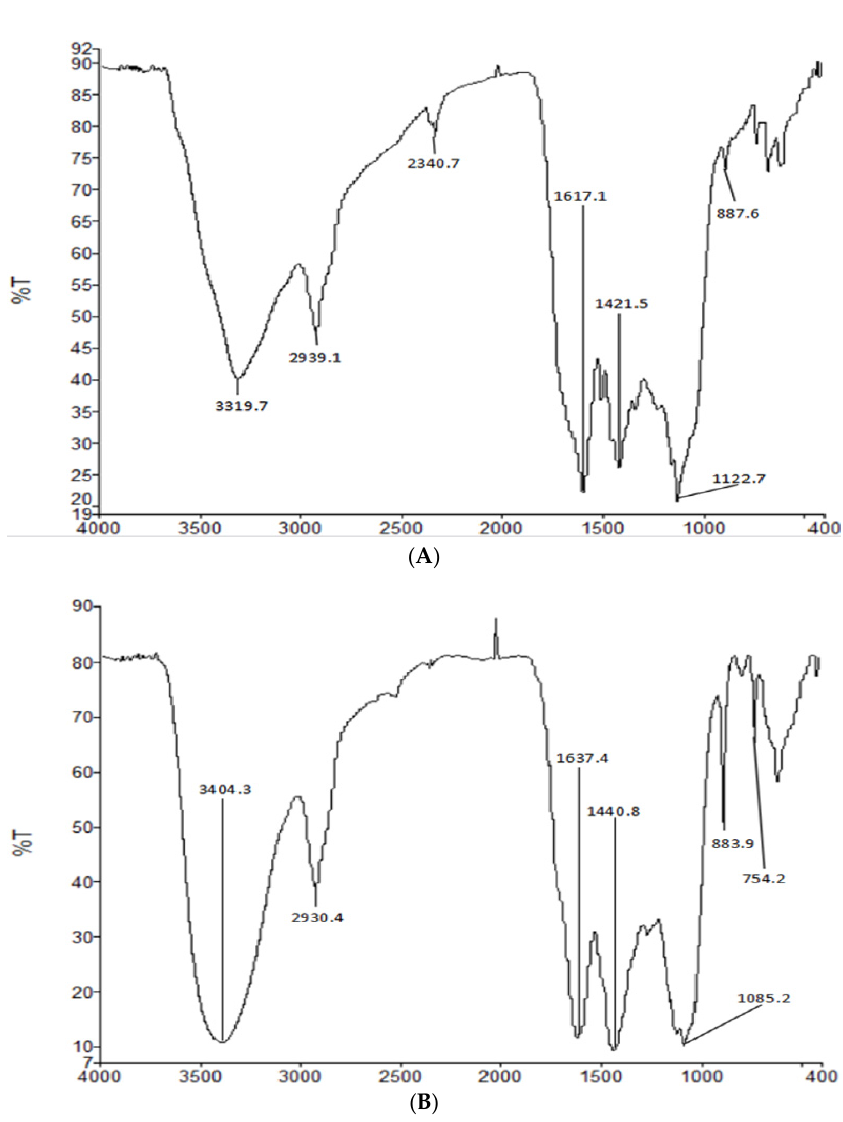
Figure 3. ( A ) Fourier transform infrared spectroscopy of HIOP1 ‐ S; ( B ) Fourier transform infrared spectroscopy of HIOP2 ‐ S.